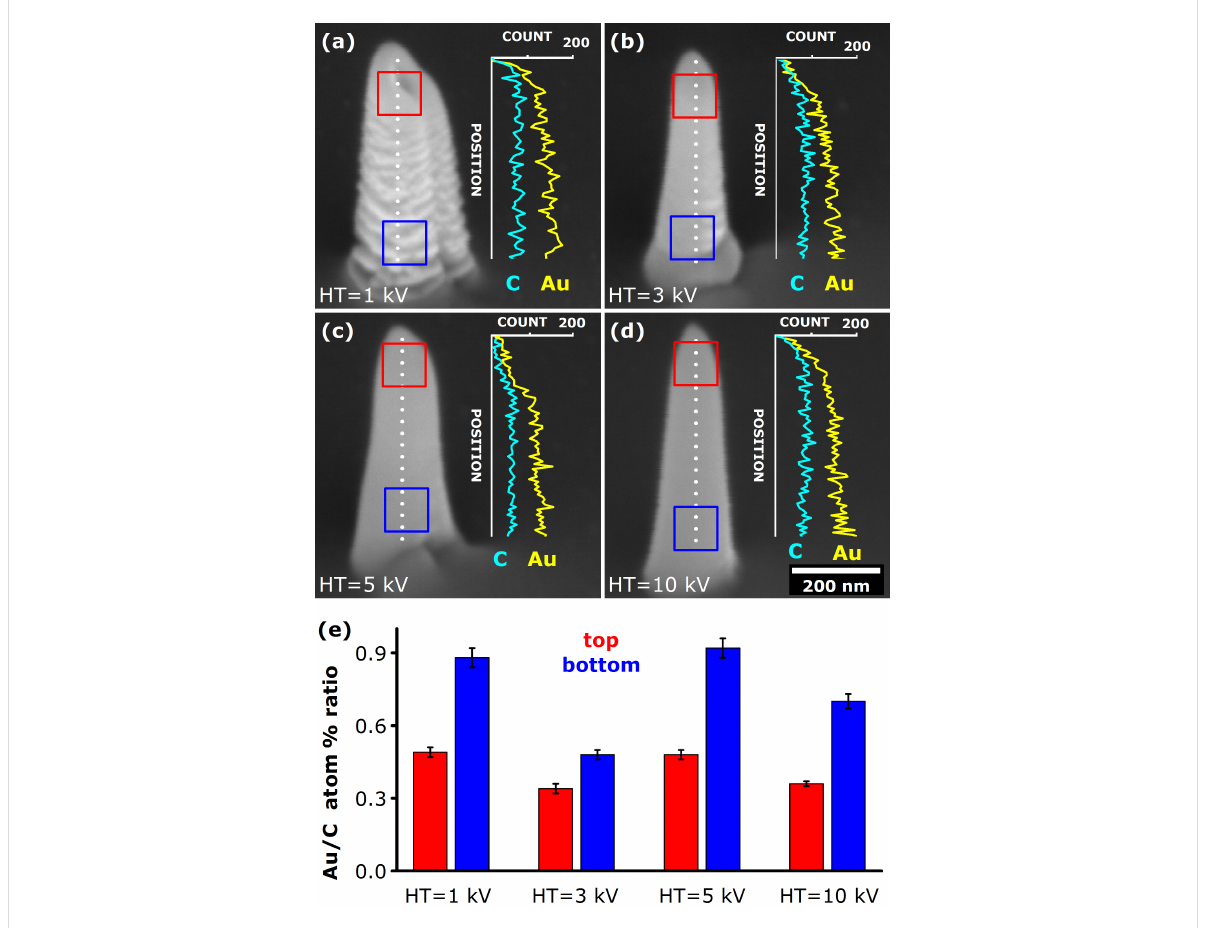
Figure 2: (a)–(d) SEM images (45° tilt) and the corresponding EDX line profiles taken along the height of the Au nanopillars (NPs), as indicated by the dotted line (to the scale). These vertical NPs were deposited for 60 s using an electron beam current of 1 nA for various acceleration voltage values, as indicated in the images. By definition, the top section relates to the top quarter of the NP, whilst the bottom section relates to the bottom quarter, as indicated by the red and blue squares, respectively. The scale bar applies to all SEM images in this Figure. (e) Elemental composition in the top and bottom sections of samples presented in (a–d), expressed in terms of Au/C atom % ratio. The EDX measurements were performed on 100 × 100 nm 2 areas with an acquisition period of 60 s. For detailed EDX data see Table S1 in Supporting Information File 1.